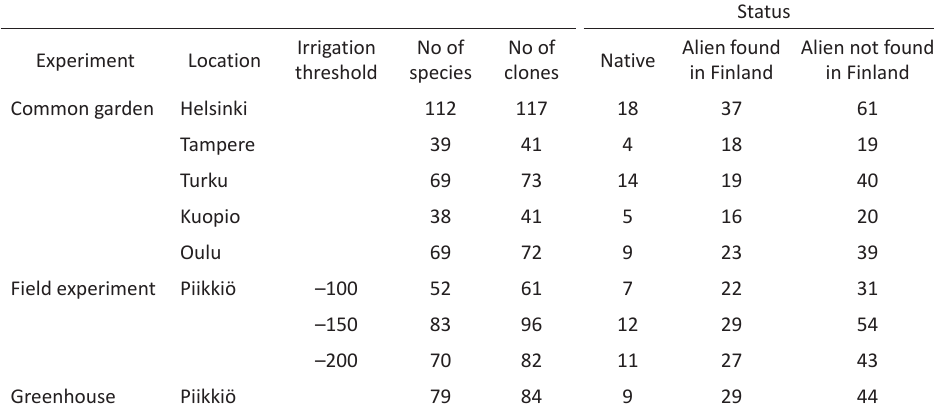
Table 1. Number of species and clones observed in common gardens, in moisture controlled field experiment and in greenhouse